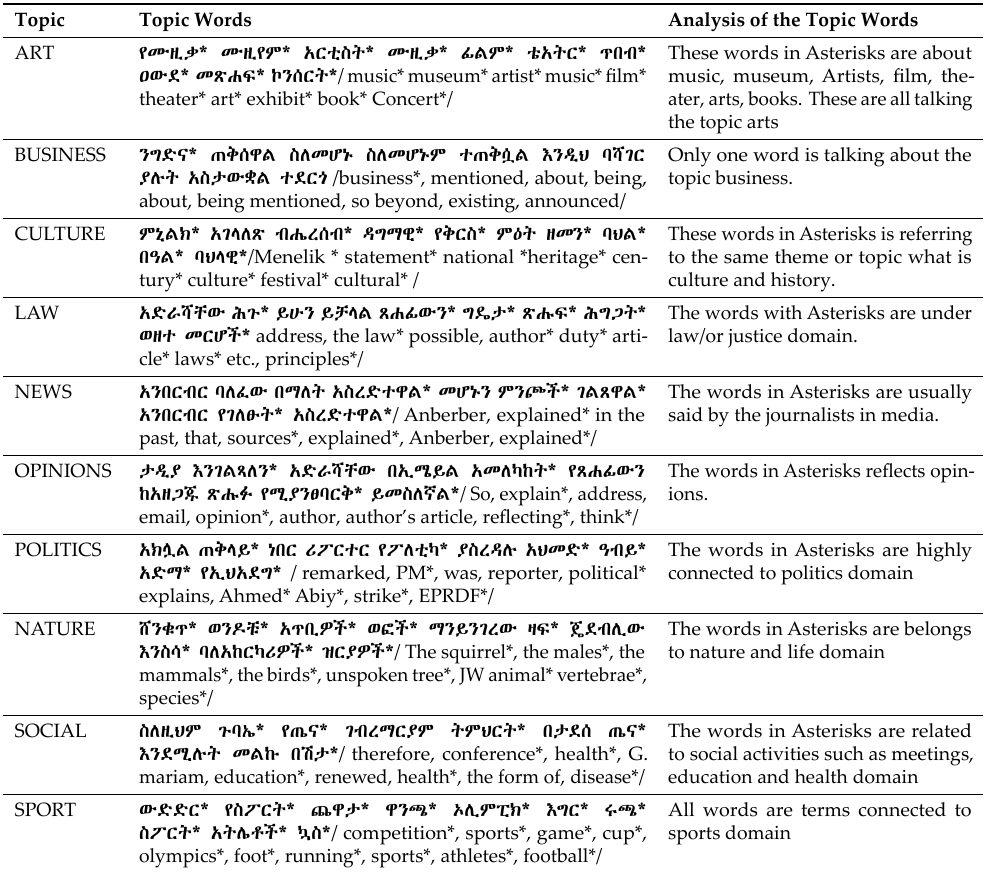
Table 6. Sample Topic-Terms Generated by SVM Topic Classifier. Asterisks indicates meaningful topic